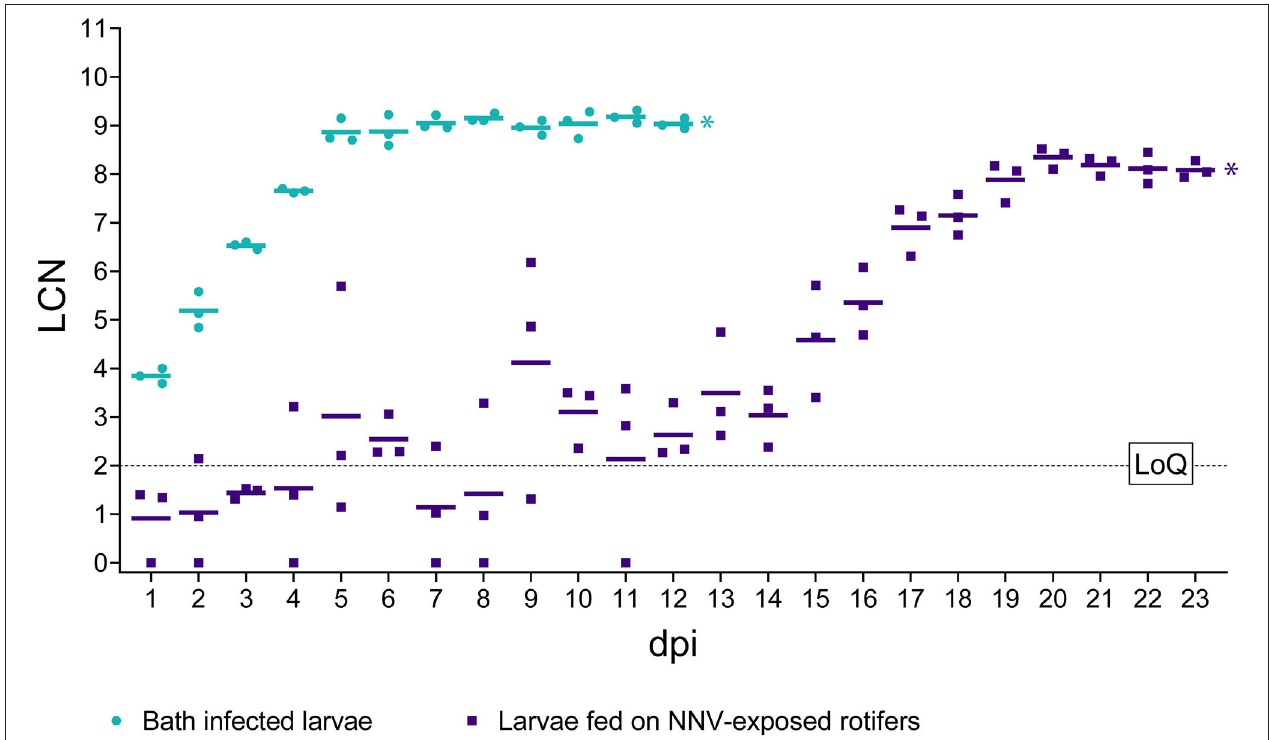
FIGURE 5 | RT-qPCR results in challenged larvae. The x -axis represents the observation period expressed as days post-infection (dpi). The y -axis represents Log 10 of RNA1 copy numbers (LCN) detected in 20 ng of total RNA. Results from bath infected larvae are depicted as green circles, while from larvae fed on NNV-exposed rotifers results are depicted as purple squares. Mean LCN values of the three replicates, per time point, are reported as short horizontal lines. A dashed horizontal line indicates the limit of quantification (LoQ). * Indicates the achievement of total mortality in both